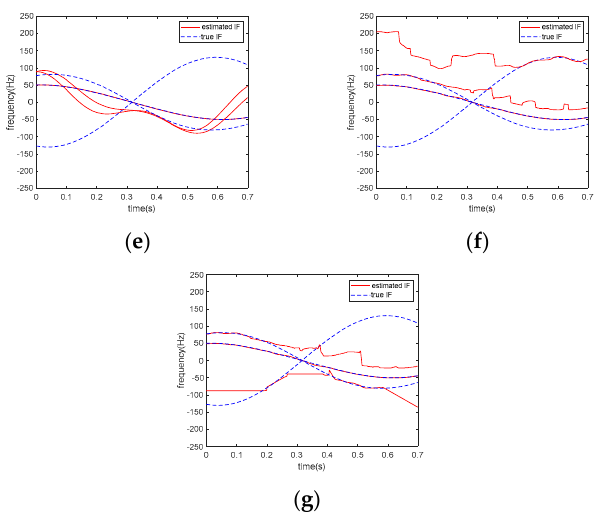
Figure 11. TF spectrums and IF estimation results for example 4 with SNR = 5 dB. ( a ) TF representation acquired by STFT; ( b ) TF representation acquired by SET. ( c ) MKF; ( d ) MTT; ( e ) CSRDI-MGPTF; ( f ) MD-STFT; ( g ) MD-SET.